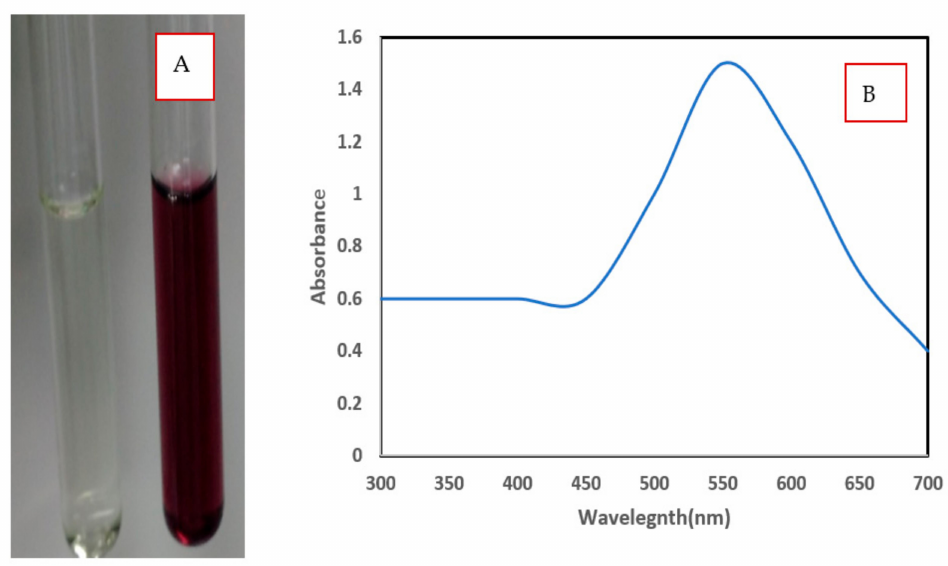
Figure 1. ( A ) The synthesis of AuNPs using green alga Chlorella vulgaris was confirmed by changes in solution from colorless to purple color, ( B ) UV-Vis spectra of AuNPs synthesized using green alga Chlorella vulgaris